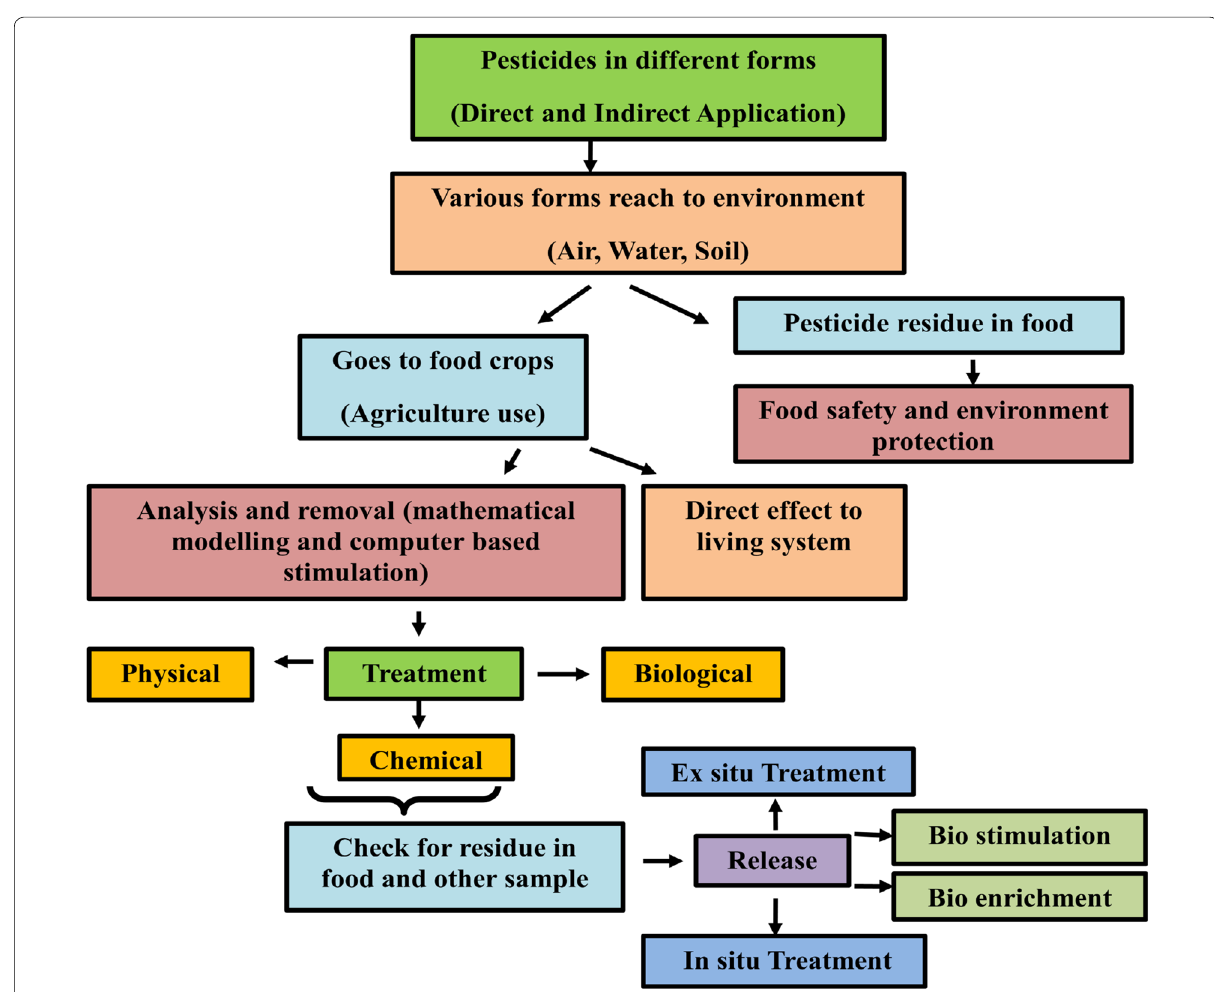
Fig. 1 Fate, transport and release of pesticides into the